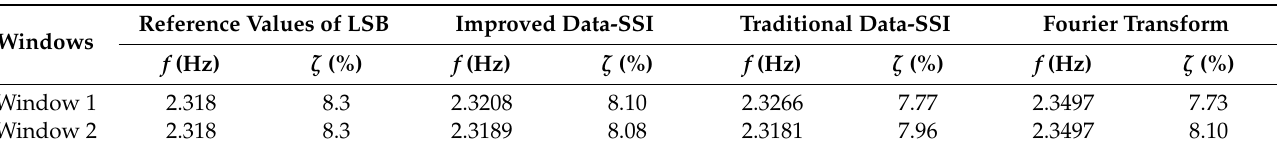
Figure 6. Results of boxplot data filtering for dynamic deflections of Beishatan Bridge. ( a ) Results of boxplot data filtering of dynamic deflections for the RSB and ( b ) results of boxplot data filtering of dynamic deflections for the LSB. Table 4. Estimated modal parameters of Beishatan Bridge for the improved Data-SSI, traditional Data-SSI, and Fourier